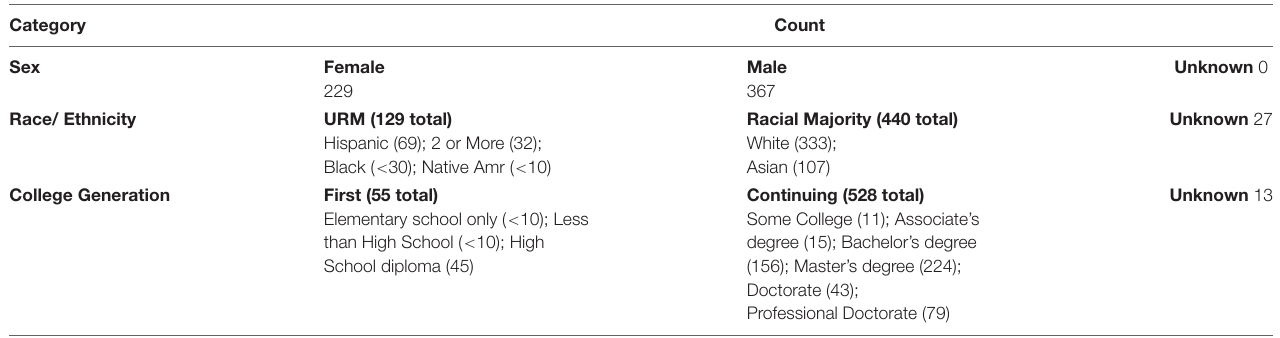
TABLE 1 | Number of students in each identity group in Winter 2018, with race/ethnicity and maximum parental education used to determine college generation disaggregated by the categories used by the